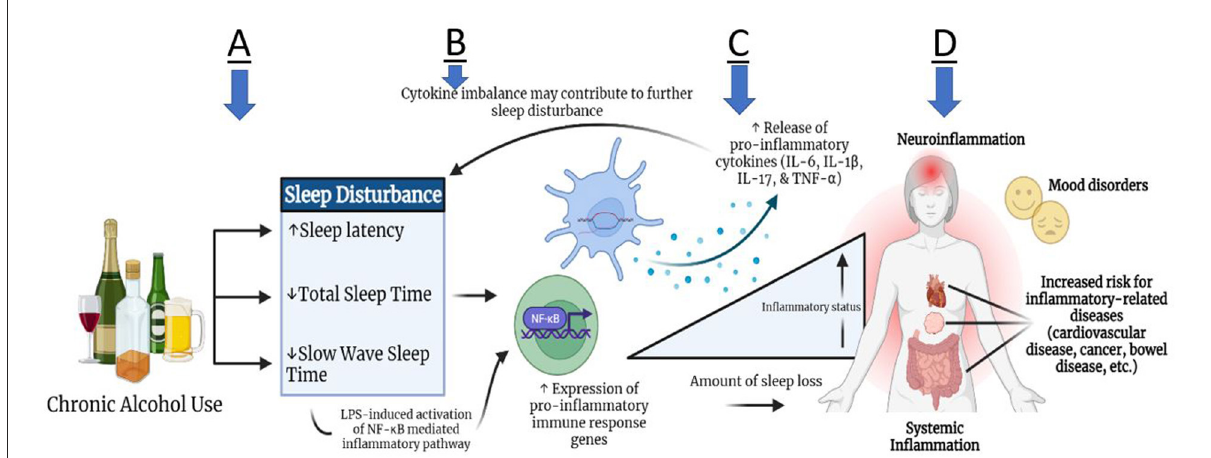
FIGURE1 Theoretical relationship between alcohol use and sleep disturbance with inflammation. Subsequent to chronic alcohol use, some individuals may experience increased sleep latency, as well as decreased total sleep time and slow wave sleep time (A) . These sleep disturbances may contribute to heightened expression of pro-inflammatory immune response genes through the mechanism of toll-like receptor signaling, leading to leaked lipopolysaccharides (LPS) in plasma. LPS propagates the signal through different pathways, such as NF- κ B, and induces cytokine production peripherally and in the brain (B) . Pro-inflammatory cytokine production (IL-6, IL-1 β , IL-17, TNF- α ) can lead to systemic inflammation and neuro-inflammation (C,D) . Due to the bidirectional link between the brain and periphery, the inflammatory activity can in turn lead to further altered sleep architecture. Ultimately, persistent inflammation can lead to an increased risk for inflammation-related comorbidities, such as cardiovascular disease, cancer, bowel diseases, and mood disorders (D)